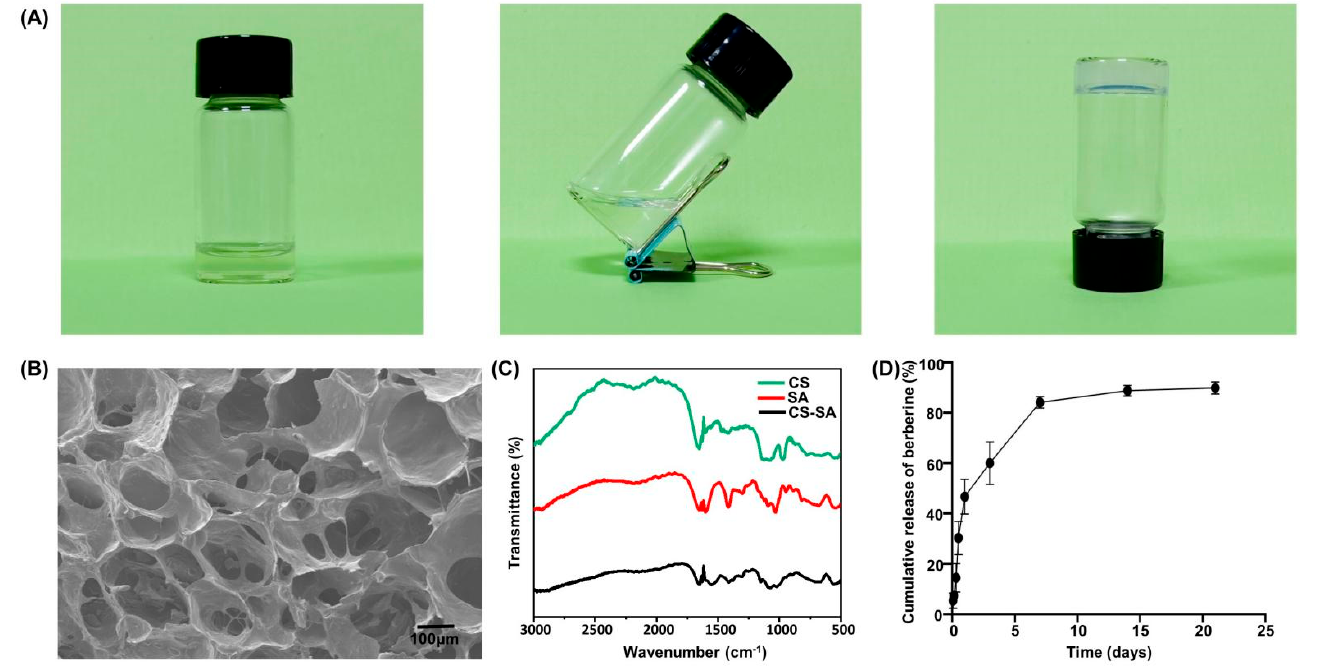
Figure 1. Characterizations of the thermosensitive hydrogel. ( A ) Image of CS/ β –GP/SA mixed solution transformed into hydrogel after 3 min at 37 ◦ C. ( B ) SEM image of the thermosensitive hydrogel. ( C ) Fourier transform infrared spectrometry (FTIR) spectra for thermosensitive hydrogel. ( D ) The release percentage curve of berberine from the thermosensitive